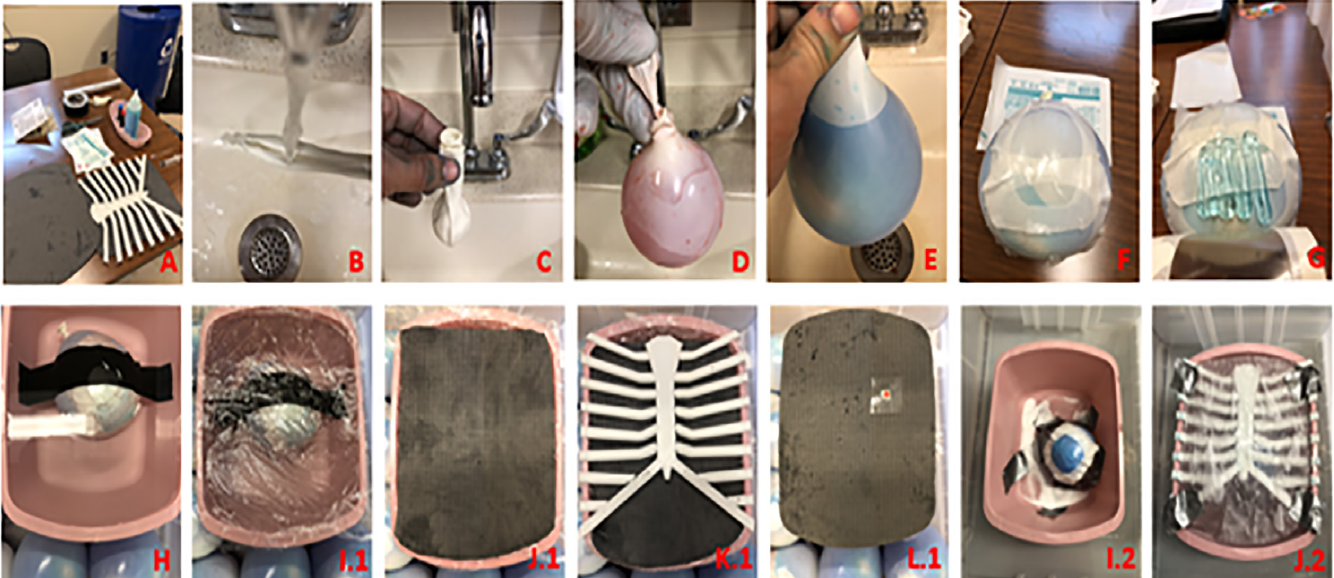
Figure 1. Design step-by-step progression: A. All supplies minus wash basin. B. Run warm water on the inner balloon over a blunt knife. C. Pass balloon inside outer balloon using knife. D. Place a drop of red food coloring and fill the inner balloon. E. Place a drop of blue food color - ing and fill the outer balloon. F. Place a layer of Tegaderm on the outer balloon. G. Add a layer of ultrasound gel between layers of Tegaderm. H. Tape balloon to bottom of dry water basin. I.1. Place a layer of plastic wrap. J.1. Place the first layer of ¼” yoga mat. K.1. Clip on anterior chest variant 1 to water basin. L.1. Place the second layer of ¼” yoga mat and add the left shoulder indicator to the mat. I.2. Add polyethylene glycol (or equivalent). J.2. Tape a layer of parchment paper over the anterior chest variant 2 and fill the water top of